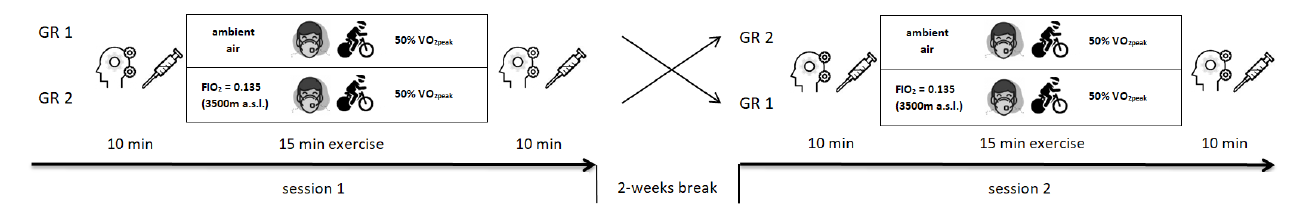
Figure 1. Overview of the experimental protocol.